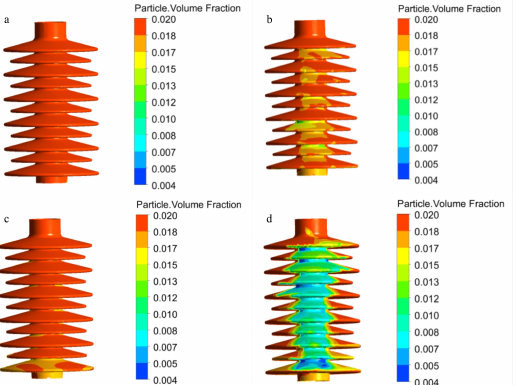
Figure 20. Distribution map of contamination on the surface of insulators.